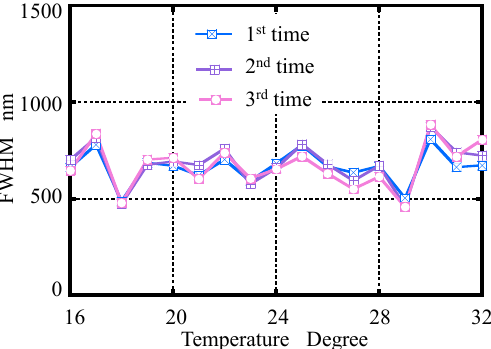
Figure 8. Full width at half maximum (FWHM) under various temperatures.